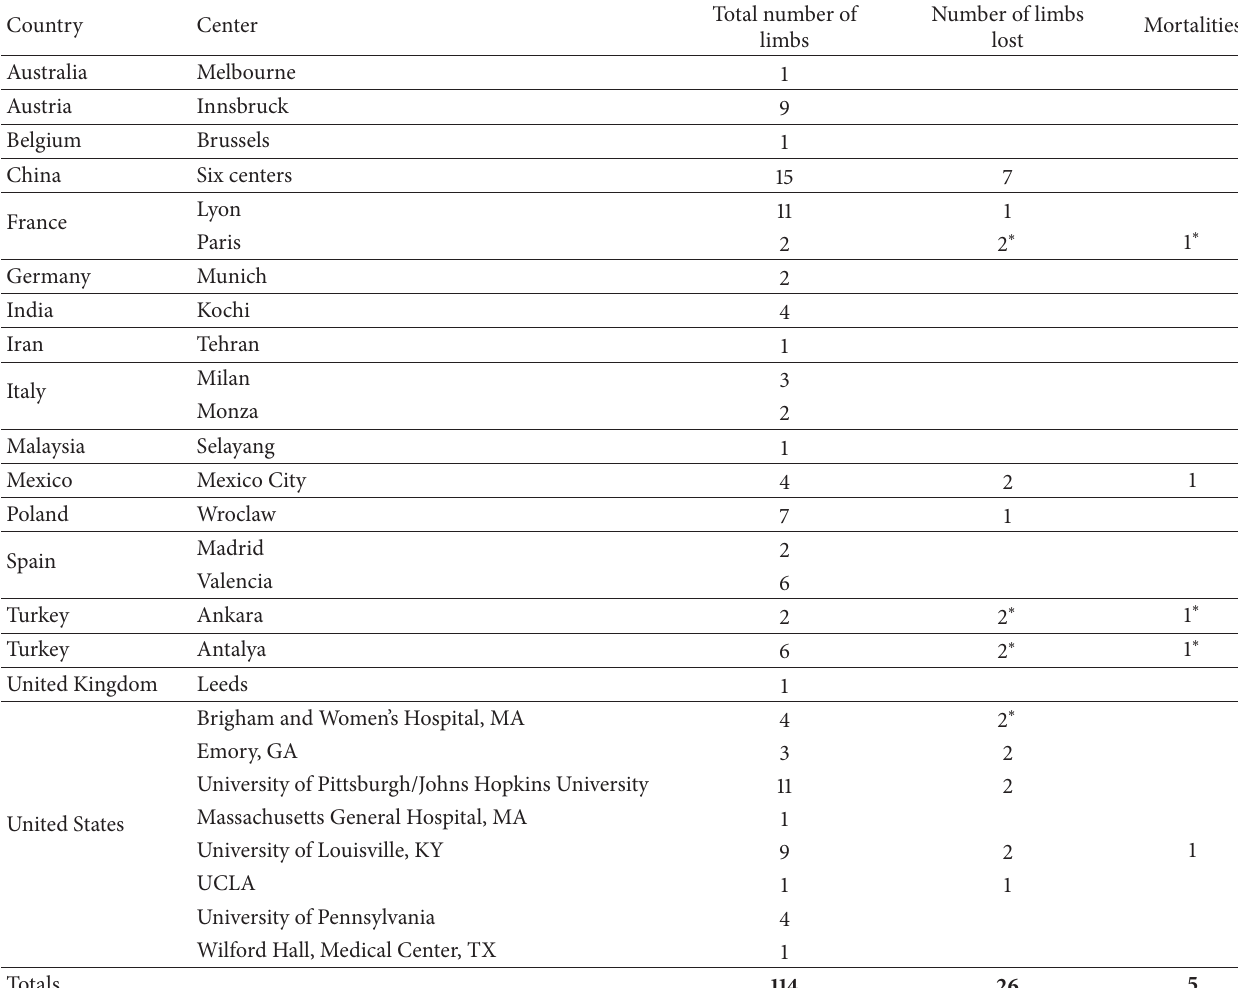
Table 1: Summary of upper extremity transplantation